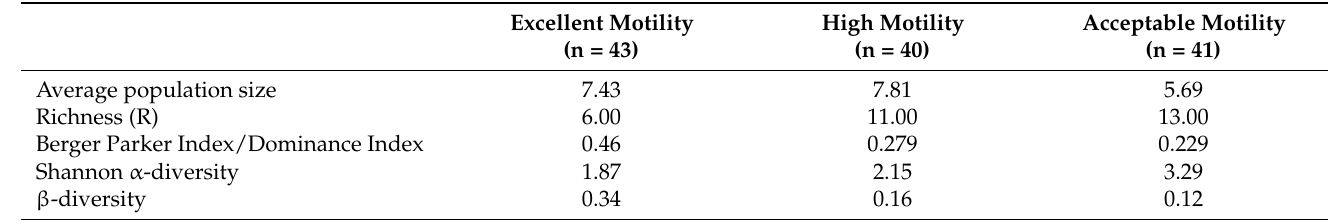
Table 6. Bacterial diversity in human semen samples divided into three groups based on their